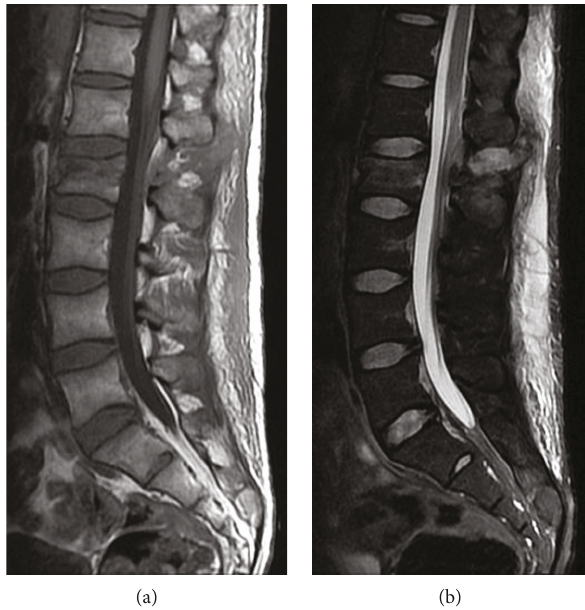
Figure 1: Preoperative magnetic resonance imaging (MRI) of the lumbar spine. (a) Midsagittal T1-weighted and (b) short tau inversion and recovery (STIR) MRI showing the L2 vertebral fracture and disruption of the posterior ligamentous complex between L1 and L2 in combination with extensive subcutaneous hematoma.